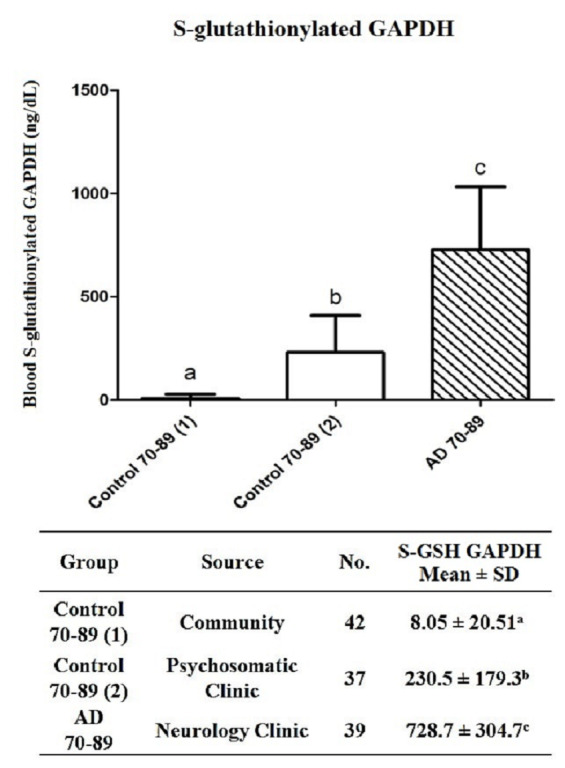
The blood S-glutathionylated GAPDH levels of the healthy controls from the community (1) are markedly lower than those of the controls from the outpatient psychosomatic clinic (2) and the patients with AD.a, b, c Different letters indicate significant differences, as determined by one-way ANOVA (p < 0.001).